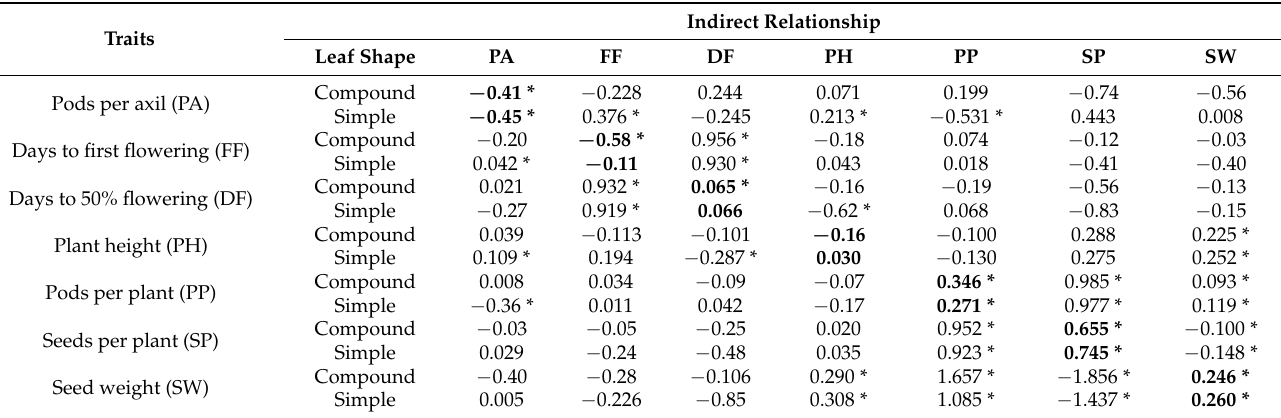
Table 4. Direct and indirect relationships among agro-morphological traits on seed yield over leaf